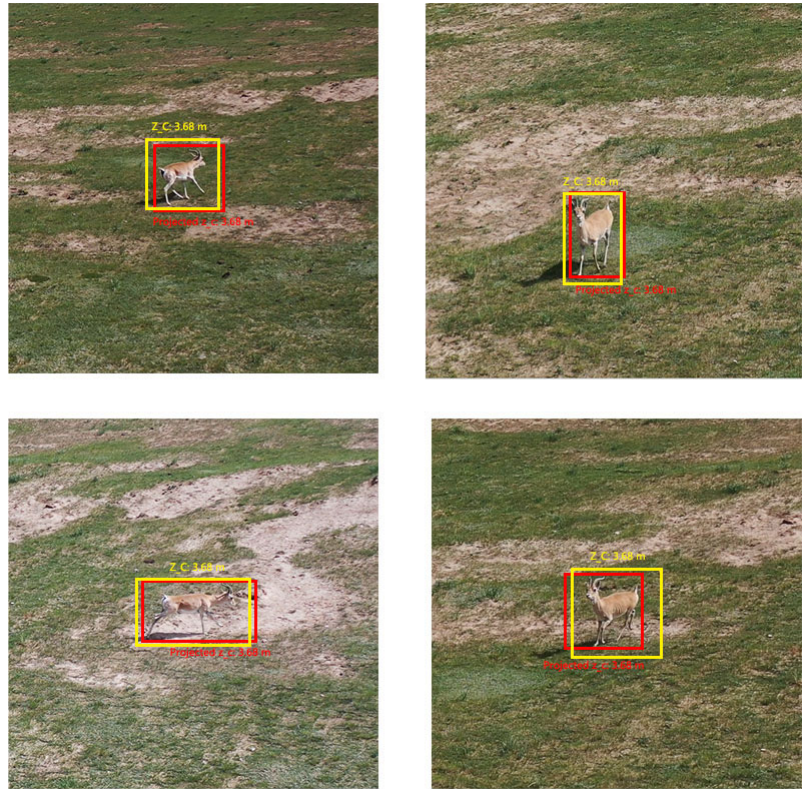
Figure 11. First-person views of the UAV system during the Procapra przewalskii track (the yellow and the red bounding boxes are the detected and predicted states of the object, respectively).